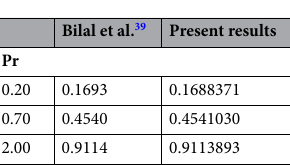
Table 3. Validation of results regarding temperature gradient when ε Hs = 0, (cid:31) = 0, δ = 0, ϕ 1 = ϕ 2 = 0.